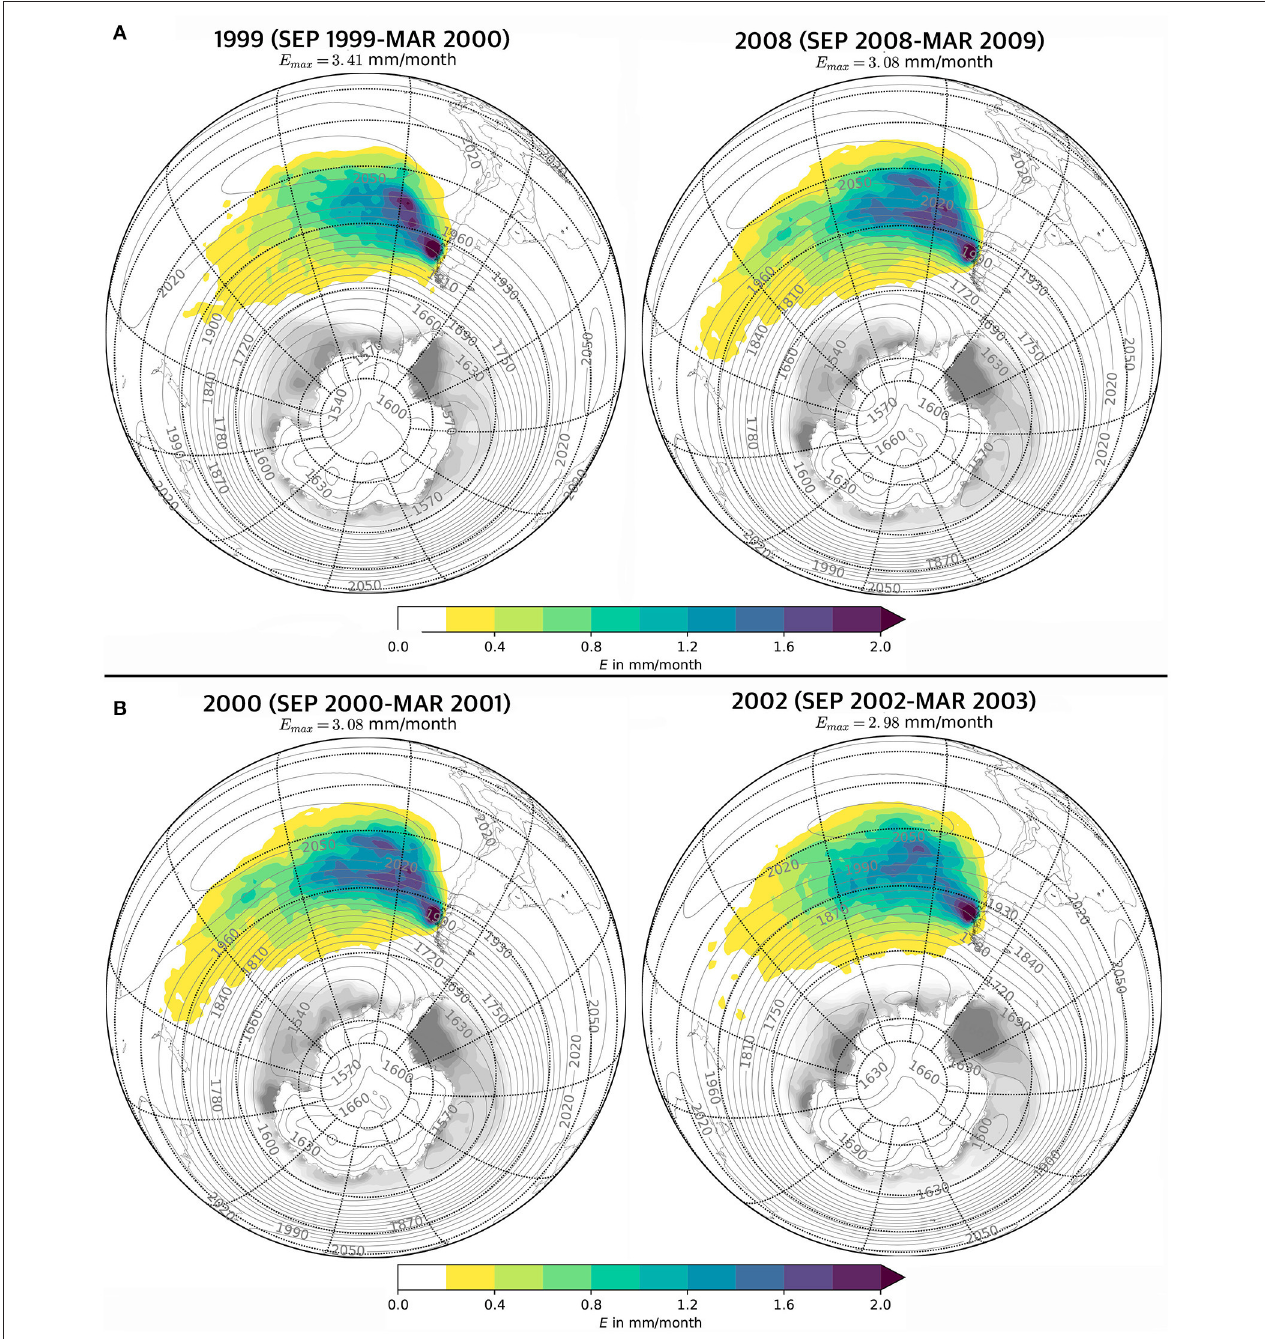
FIGURE 7 | Mean moisture sources (colored area, in mm/month) of the Southern Patagonia Icefield for the chosen (A) positive and (B) negative extreme years. The individual maximum moisture source exceeding the colorbar legend (E max ) is indicated for orientation. Gray lines indicate the average 800 hPa geopotential height and the gray shaded area the average sea ice cover during the respective time period. Interval of the Meridians is 30 ◦ , of the Parallels 15 ◦ .